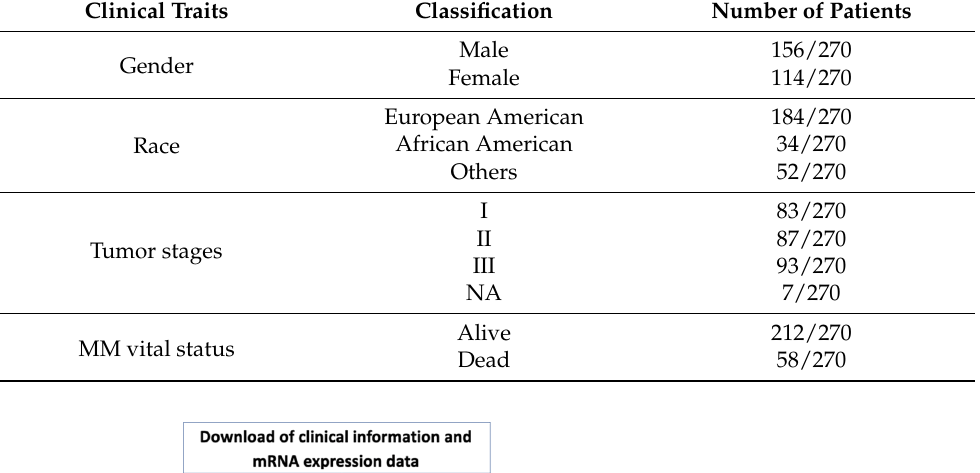
Table 1. Distribution of reported clinical traits among MM patients who received RVD therapy (some died within two years). After data normalization and outlier removal n = 270.